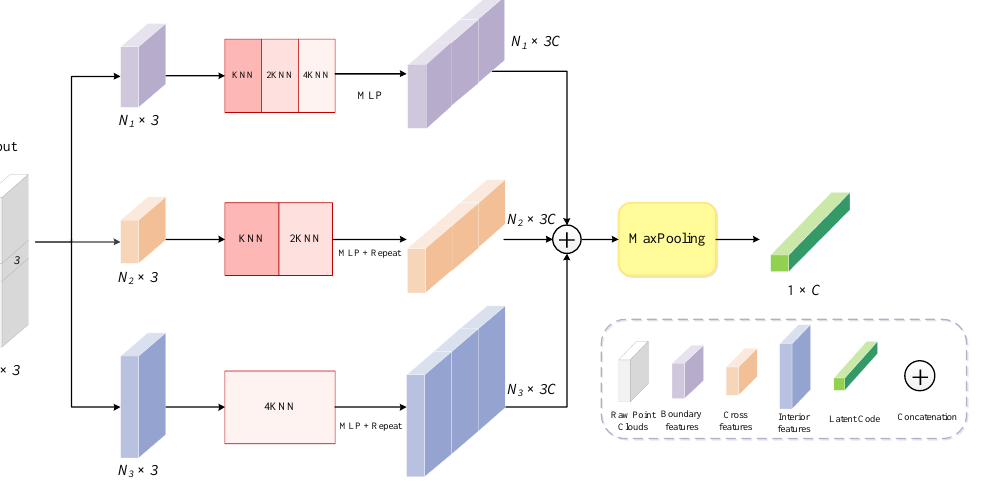
Figure 5. The construction of dilated neighborhood with different receptive fields for point clouds.